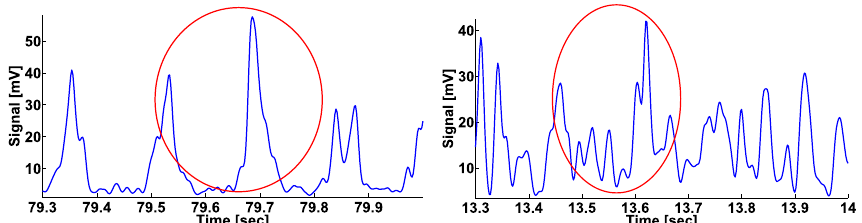
Figure 5. On the left: the envelope of the EMG signal in the tremor left hand of a PD patient. On the right: the envelope of the EMG signal in the left hand of a healthy volunteer. The wave trains are indicated by the red circles. The abscissa axis indicates the time; the ordinate axis indicates the envelope of the signal in µ V. The wave trains are very similar. We do not try to distinguish “normal” and “abnormal” wave trains. Instead, we use a statistical analysis based on the number of detected wave trains.